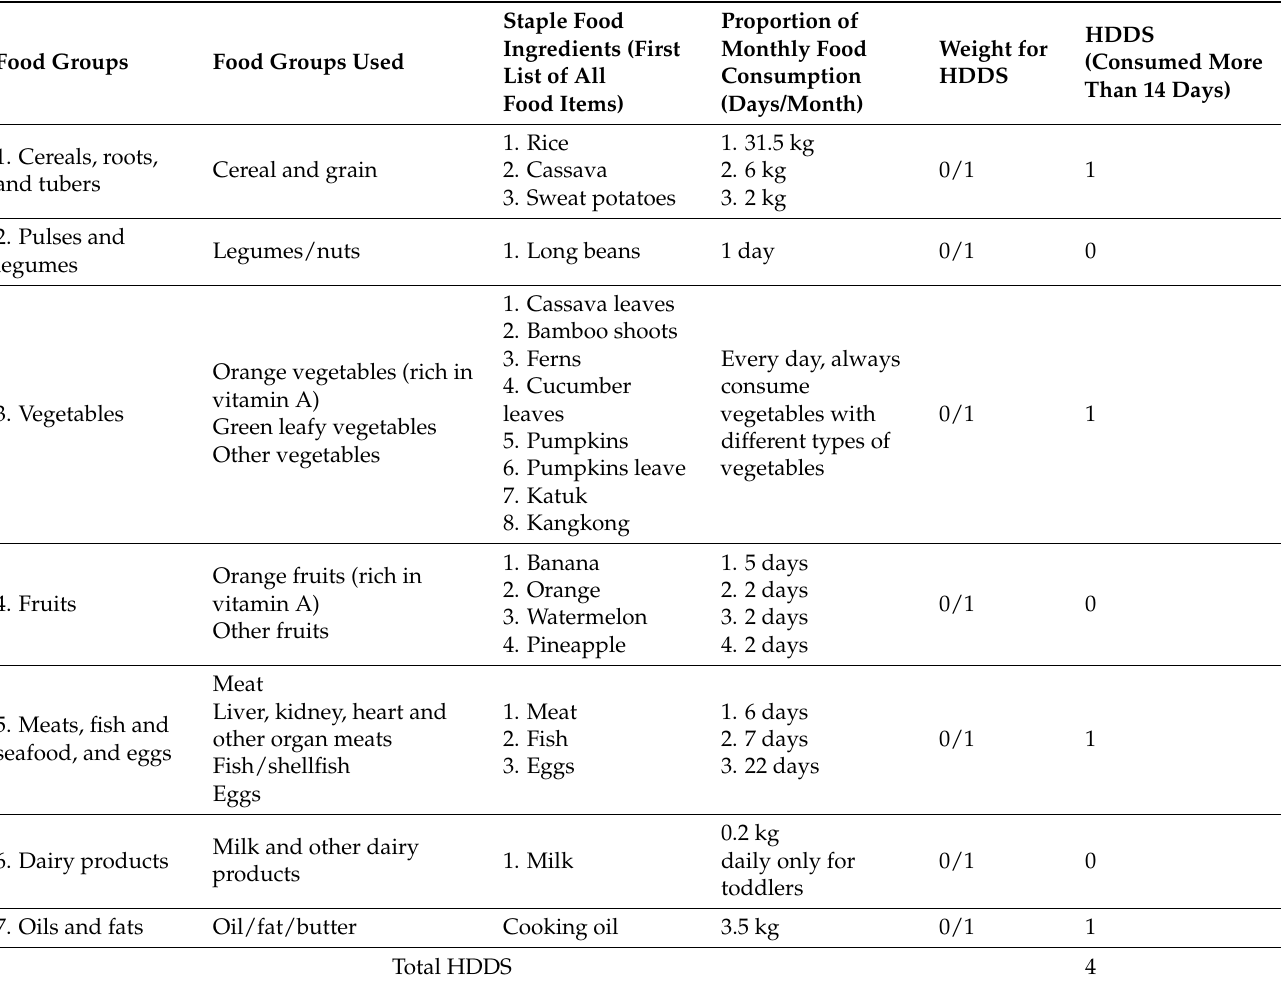
Table 11. Current HDDS of the community in the Berungkat hamlet.